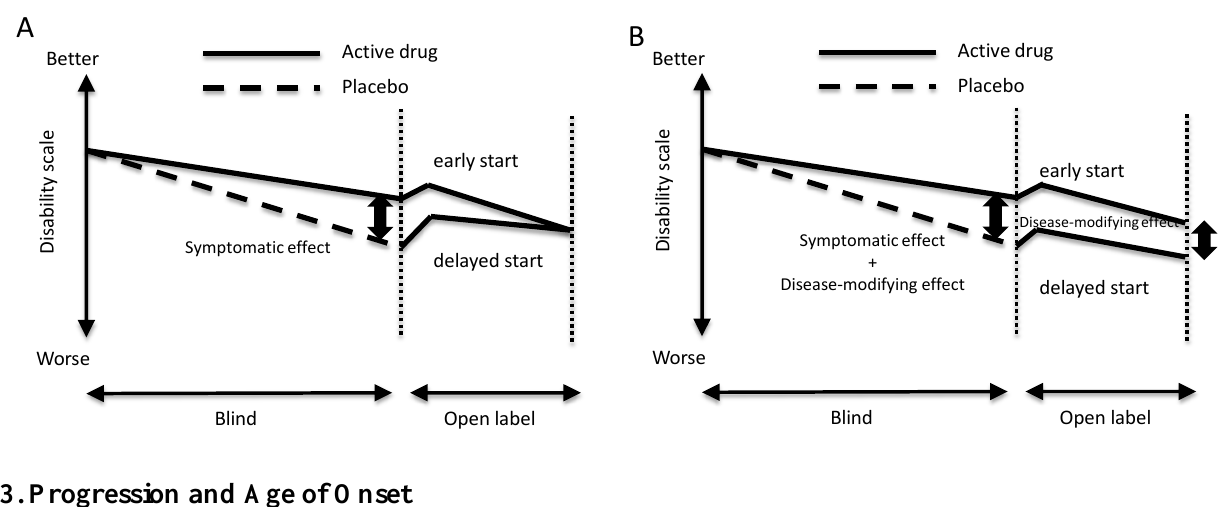
Figure 1. Study design of the delayed-start paradigm to investigate the disease-modifying effects of intervention.